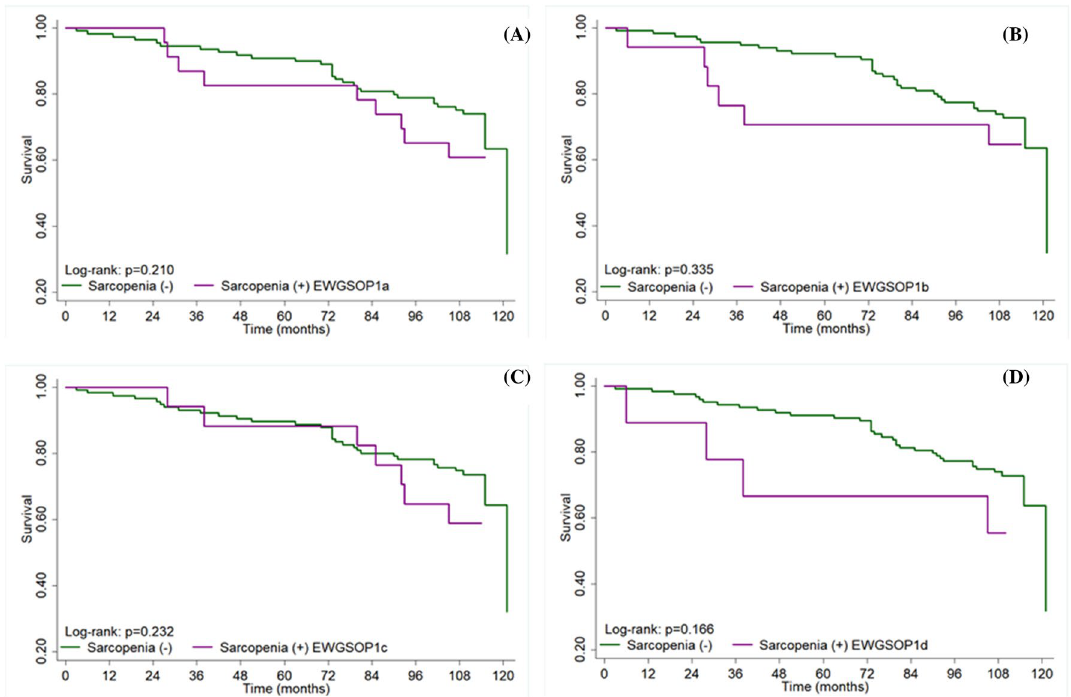
Figure 1. Survival curves according to sarcopenia status according to EWGSOP1 ( A , B ) and EWGSOP2 ( C , D ) criteria. EWGSOP European Working Group on Sarcopenia in Older People. ( A ) EWGSOP1 a : Low Calf circumference + Low Handgrip strength. ( B ) EWGSOP1 b : Low Skeletal muscle mass index + Low Handgrip strength. ( C ) EWGSOP2 c : Low Handgrip strength + Low Calf circumference. ( D ) EWGSOP2 d : Low Handgrip strength + Low Skeletal muscle mass